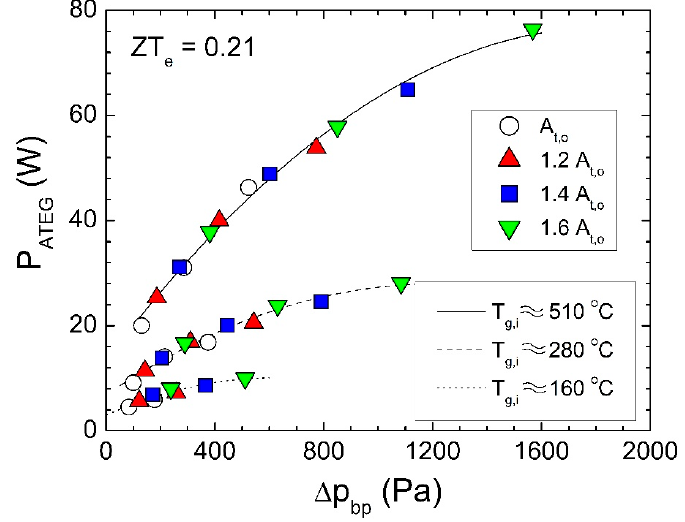
Figure 13. Electrical output power as a function of the back pressure for all cases analyzed. Numerical results.